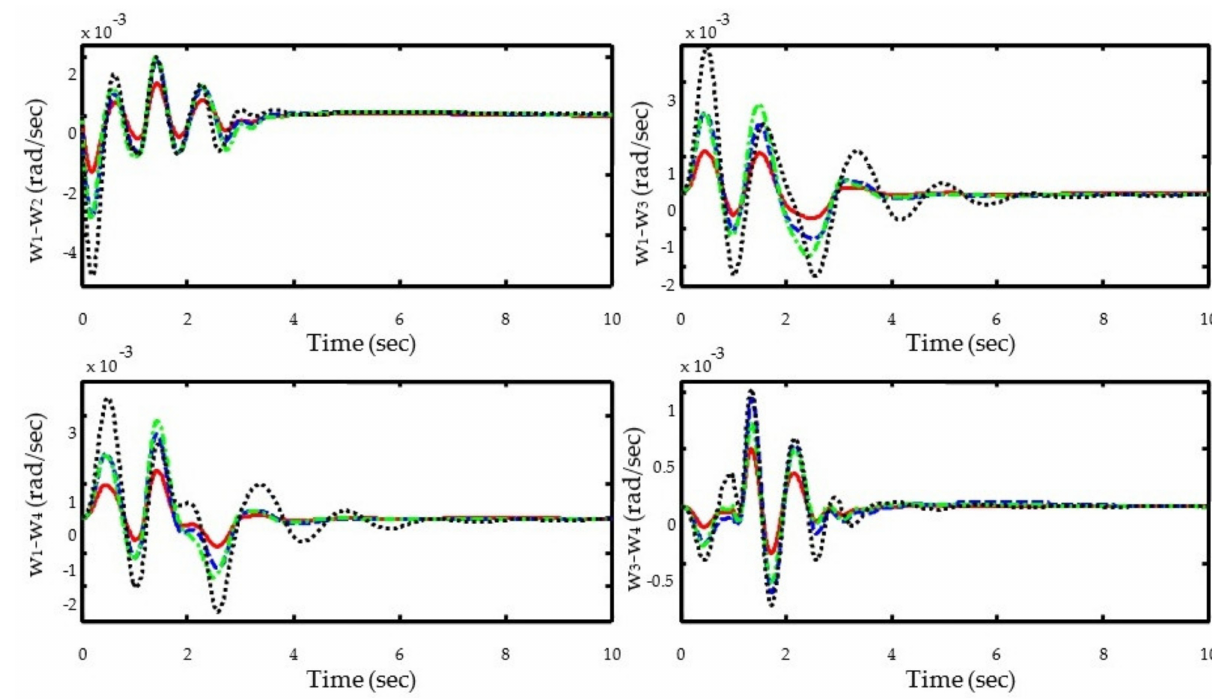
Figure 9. Angular velocity deviation for the first scenario for rated load and line disconnection; proposed (red line), BFA (blue dashed line), GA (green dash–dotted line), classic (black